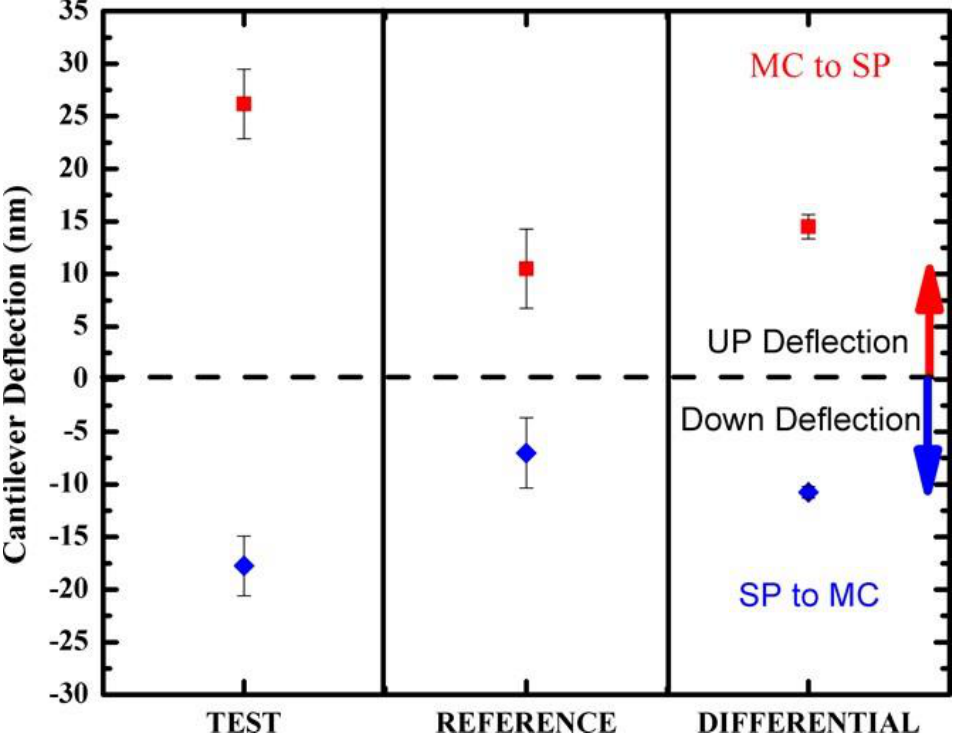
Figure 5. Average test, reference and differential microcantilever deflection response on exposure to UV and white light LEDs over five switching cycles as extracted from Figure 4.